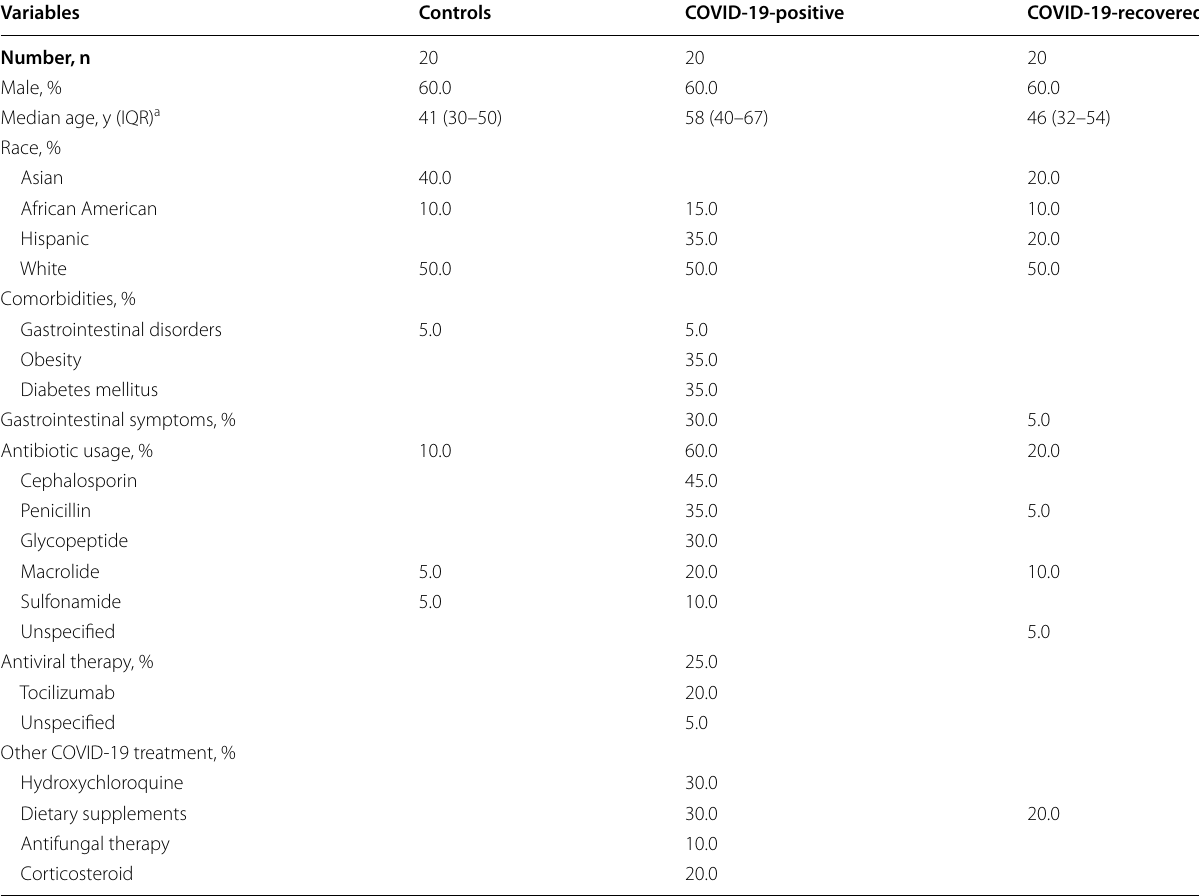
Table 1 Demographic and clinical characteristics of the 60 study